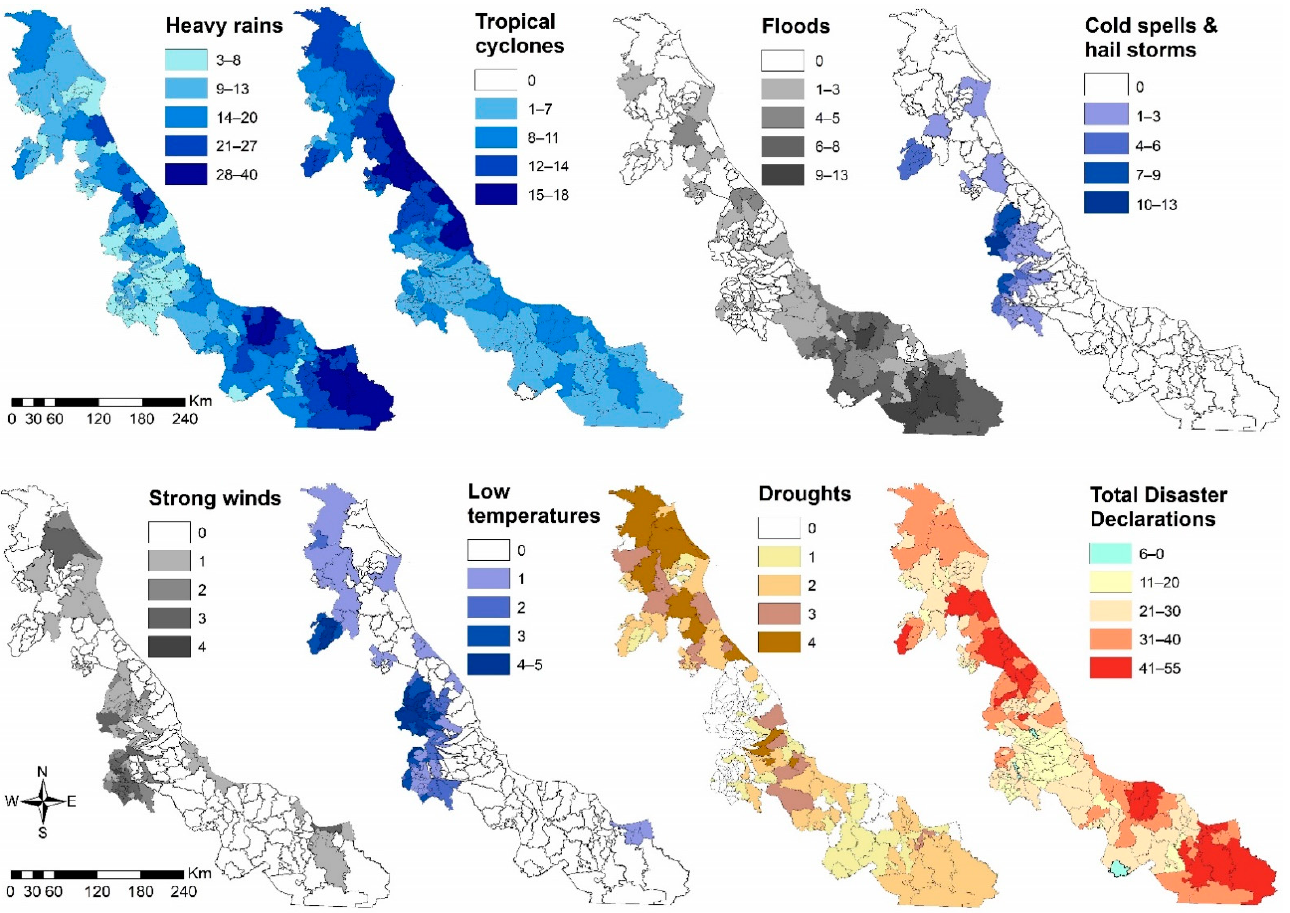
Figure 2. Type of hydrometeorological phenomena and their associated number of disaster declarations in the State of Veracruz. Source: Graphical representation created with data from the Mexican National Center to Prevent Disasters statistics [15].